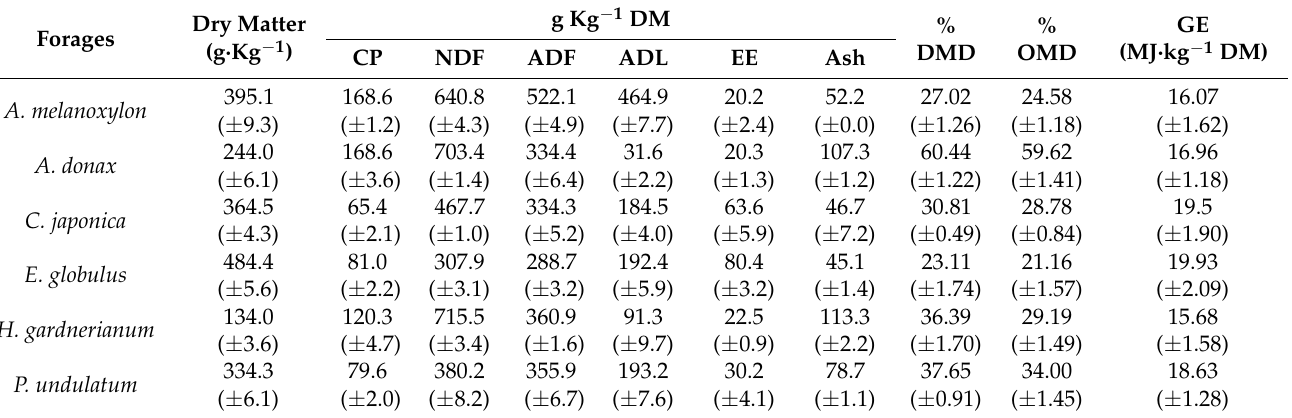
Table 1. Chemical Composition of the unconventional